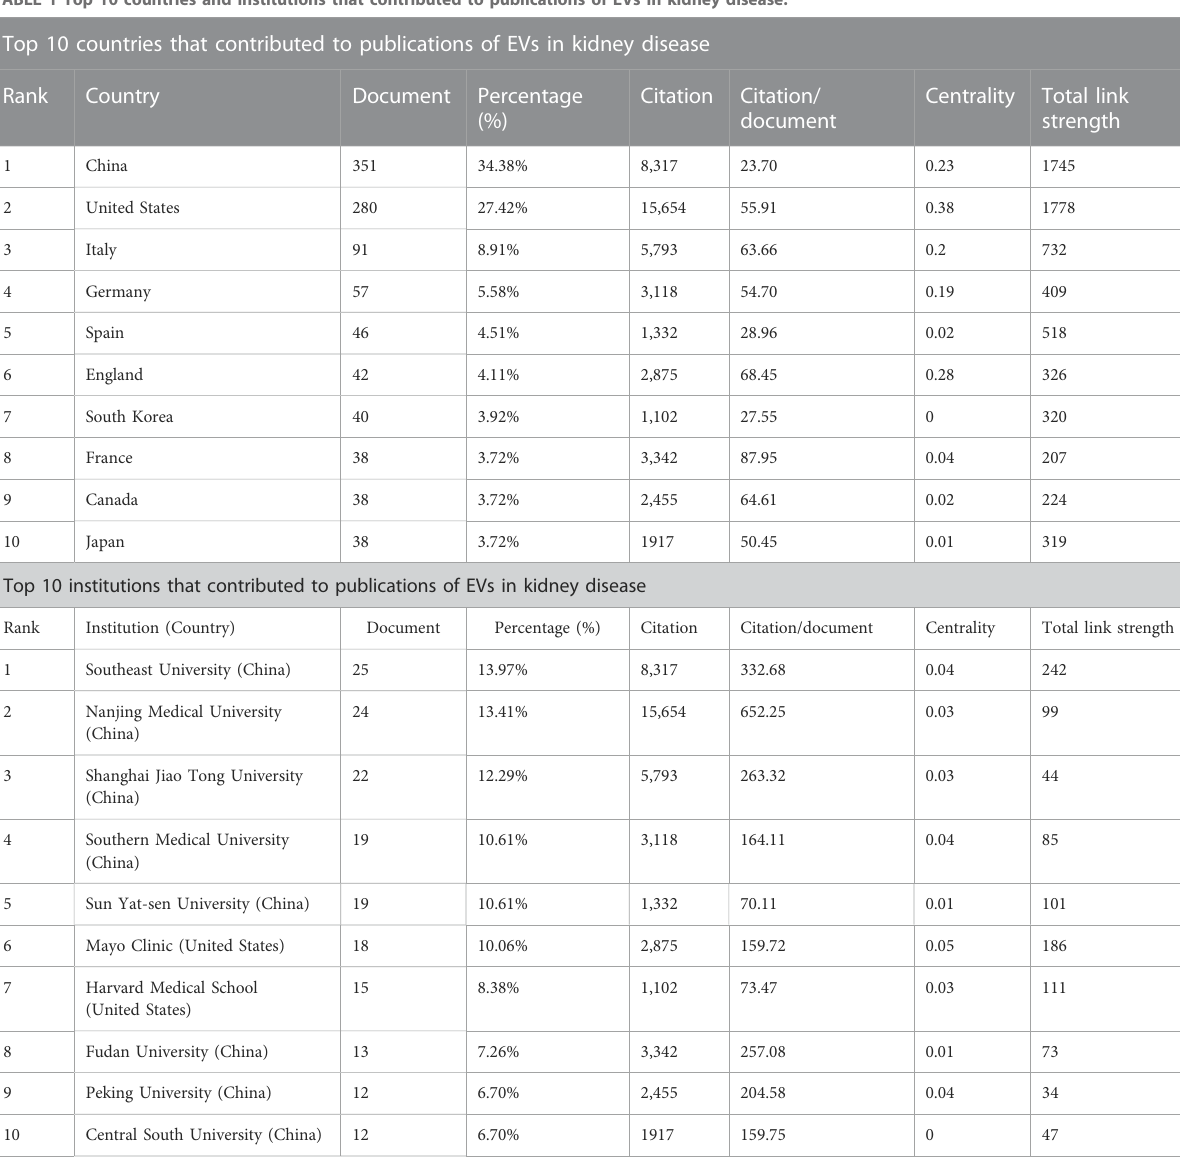
TABLE 1 Top 10 countries and institutions that contributed to publications of EVs in kidney disease. Top 10 countries that contributed to publications of EVs in kidney